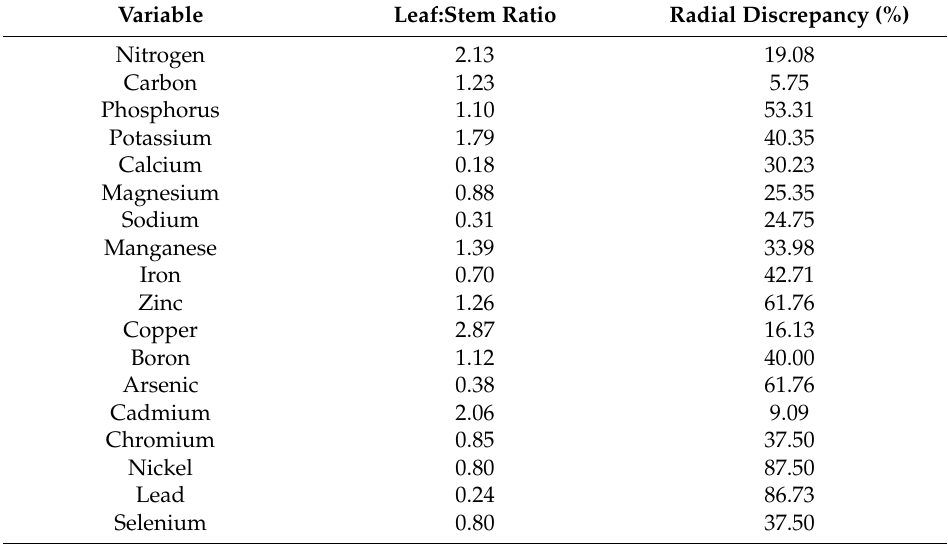
Table 5. The calculated leaf/stem ratios of concentrations of minerals and metals and the radial discrepancy of minerals and metals in stems calculated as ((maximum − minimum)/maximum) × 100 for Cycas micronesica plants. Data were presented as mean ± standard error for n =